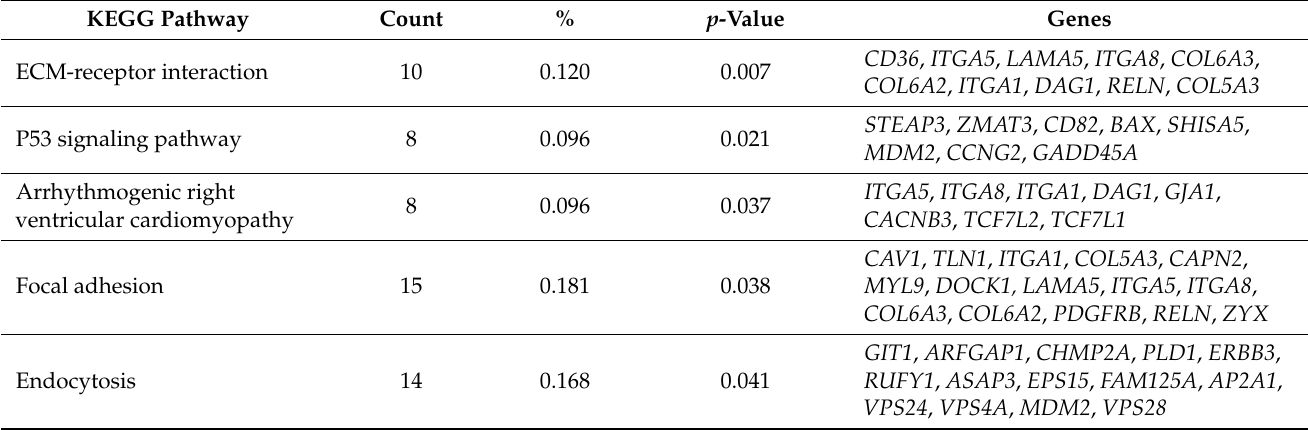
Table 1. Kyoto Encyclopedia of Genes and Genomes pathways enriched for Parkinson’s disease down-regulated genes, generated using the Database for Annotation, Visualization and Integrated